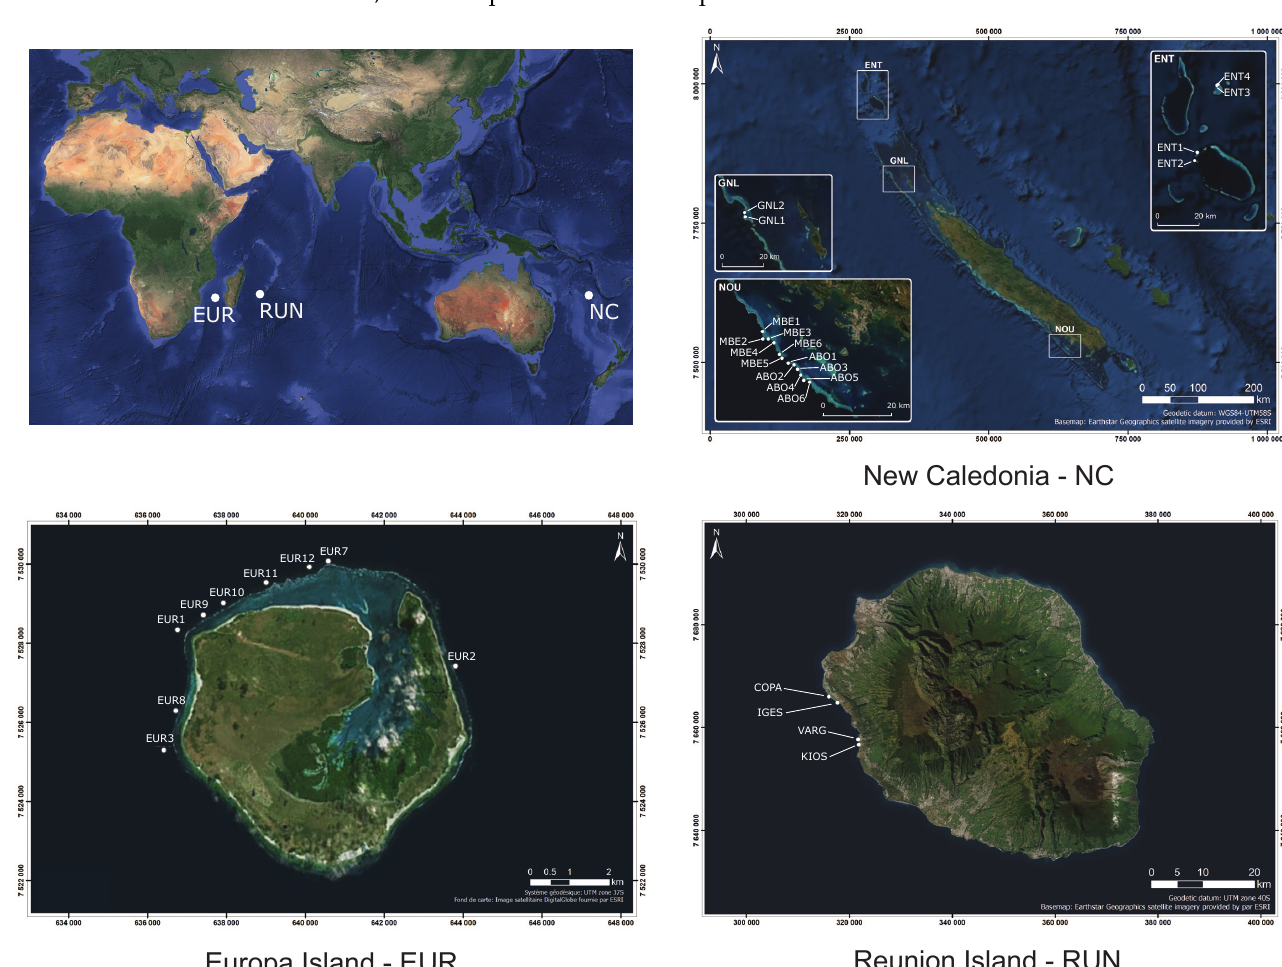
Figure 1. Location of the 31 study